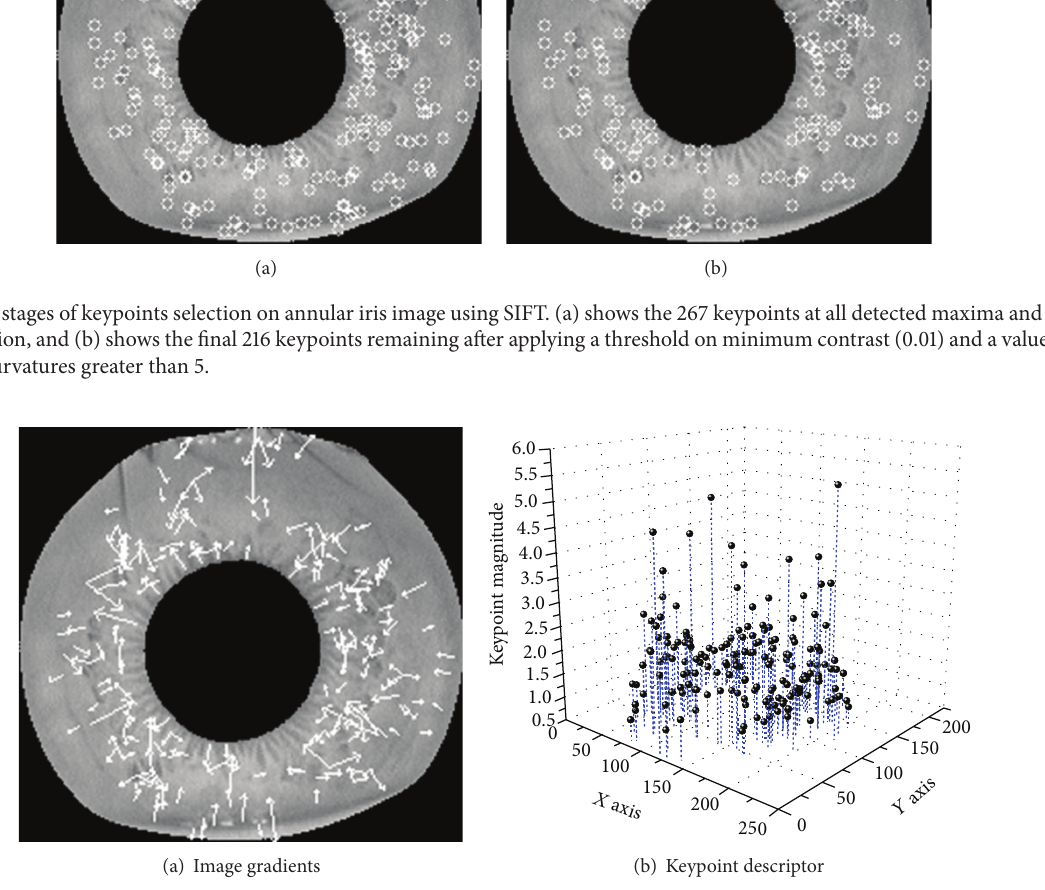
Figure 4: (a) Scale and direction of orientation is indicated by arrow in white color; (b) 3D magnitude representation of detected keypoints from annular iris